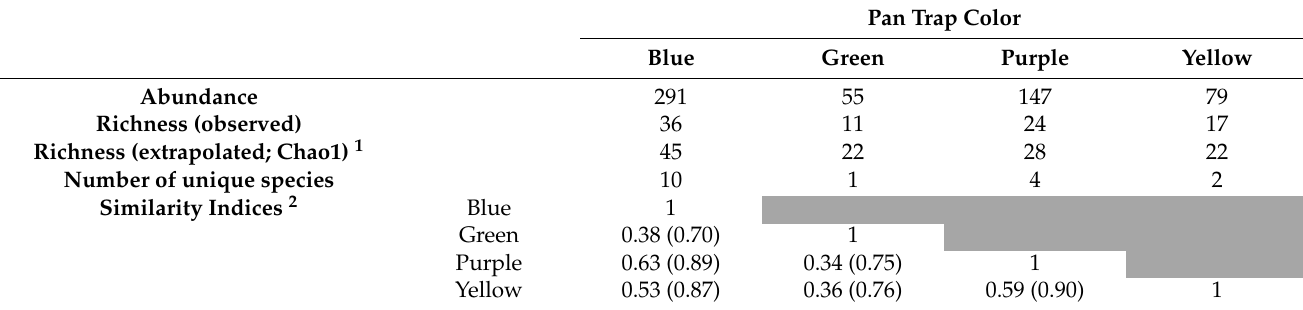
1 Rounded to nearest whole number. 2 Sorensen classic and Chao–Sorensen raw abundance-based (in parentheses) similarity indices. Blue traps had the highest number of unique species followed by purple, green and yellow traps, respectively (Table 2). Similarity in species composition based on pairwise comparisons was greatest among blue, purple and yellow traps, whereas green traps had the most dissimilar species composition when compared to other trap colors (Table 2). Ordination revealed distinct bee assemblages associated with blue traps (F = 2.06, p = 0.023) relative to other trap colors (Figure 4). This first axis on the biplot explained 3.5% of the species data and 52.3% of the species–environment relation. The secondary (vertical) axis explained an additional 2.1% of species data and 31.0% of the species–environment